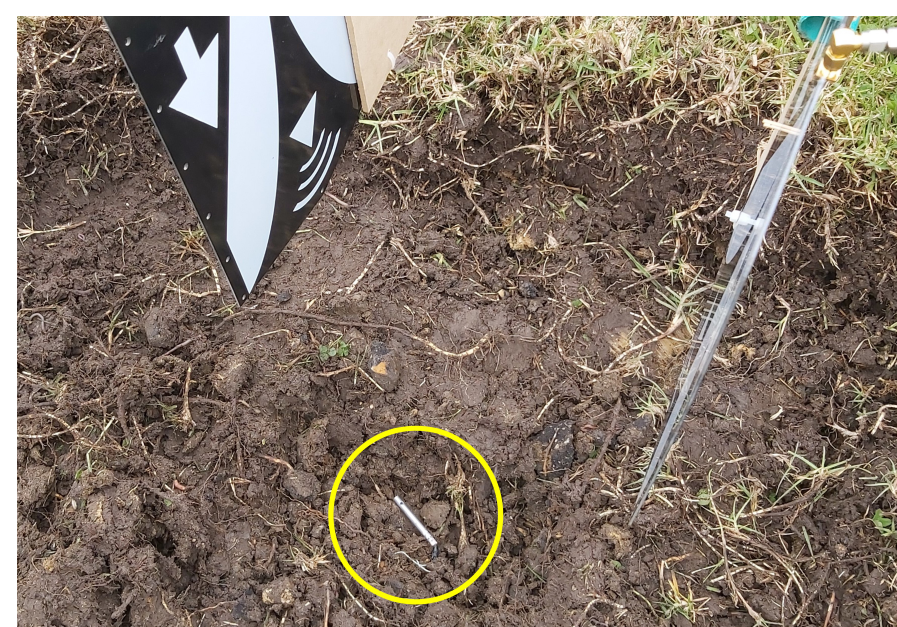
Figure 9. Buried objects experimental setup with a metal IED detonator.